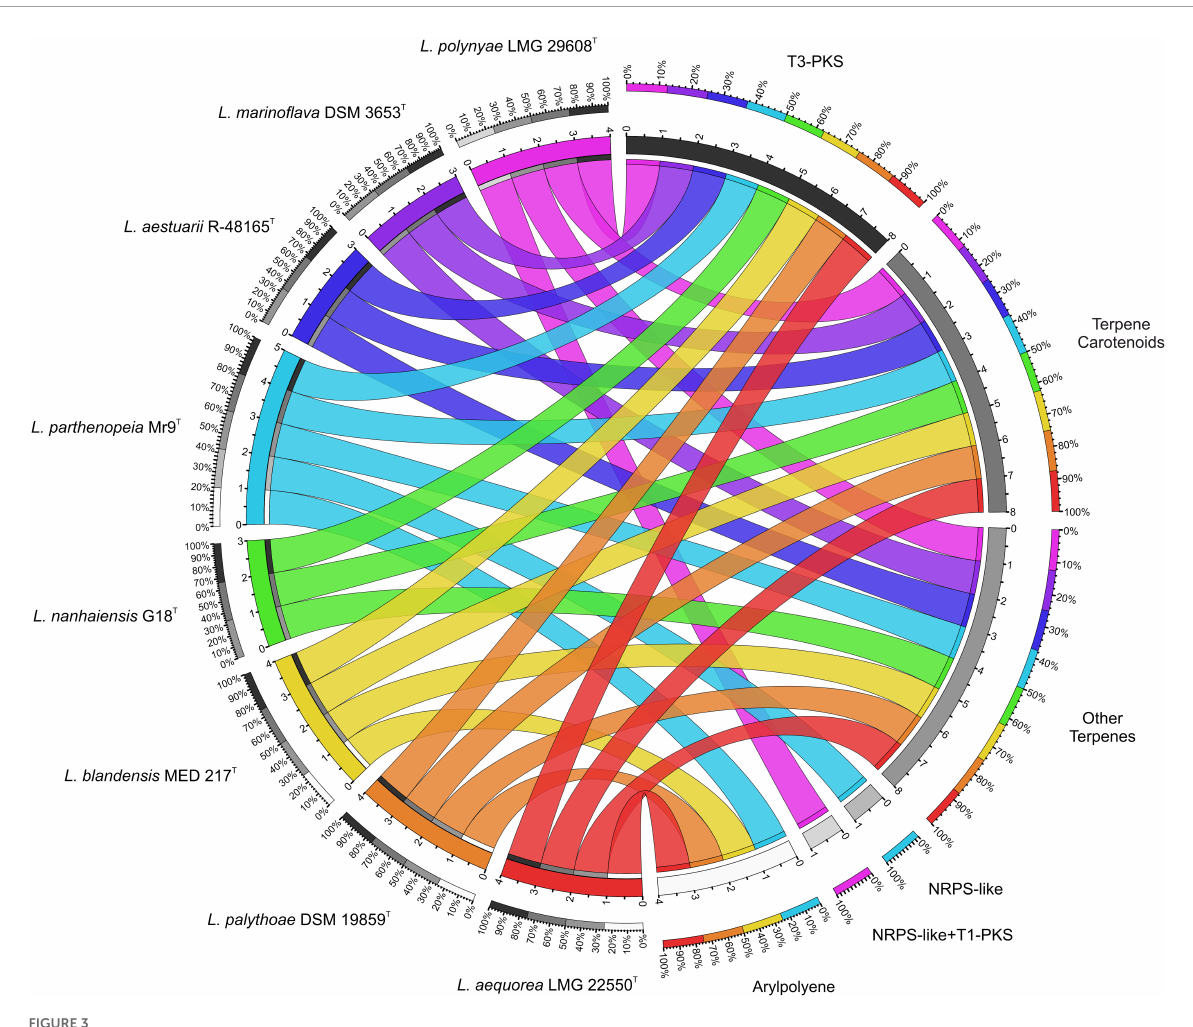
FIGURE3 Circle plot showing the relationships among the eight species of Leeuwenhoekiella (left half of the circle) and the biosynthetic gene cluster (BGC)’s diversity by typologies (right half of the circle). Each genome is represented by different colors, which are segmented according to the number of BGC content in their genomes. The chords connect both sides indicating, according to their width, the number of BGCs belonging to each typology. The outer rings in the gray scale represent the percentage of presence of BGC and in the color scale the proportion of genomes per